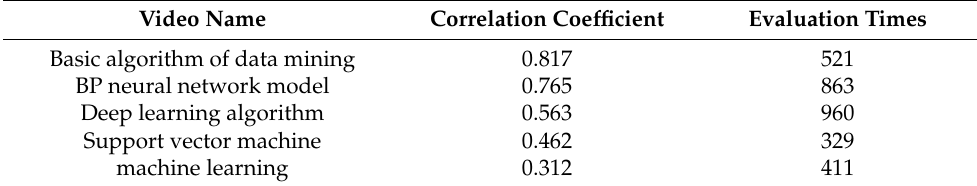
Table 14. Sorting